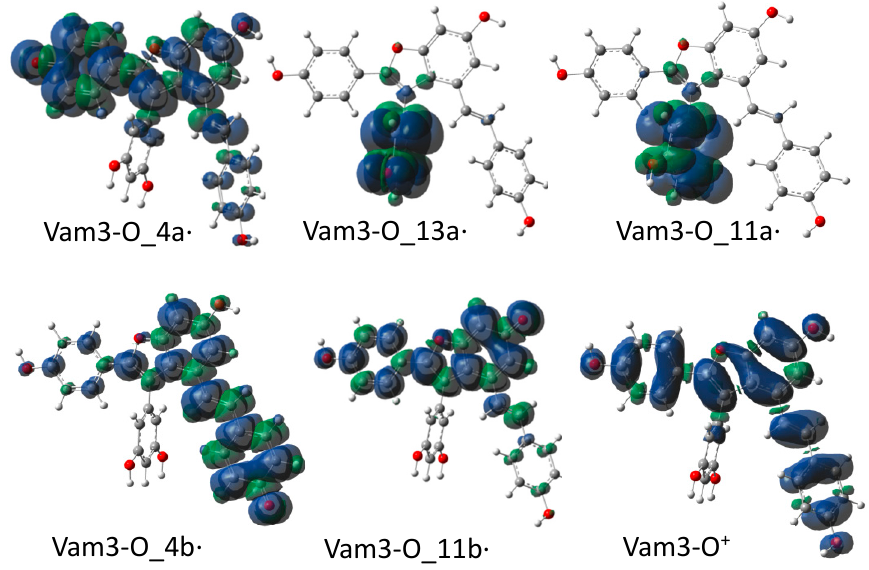
Figure 2. Spin density distribution in radical species of Vam3.